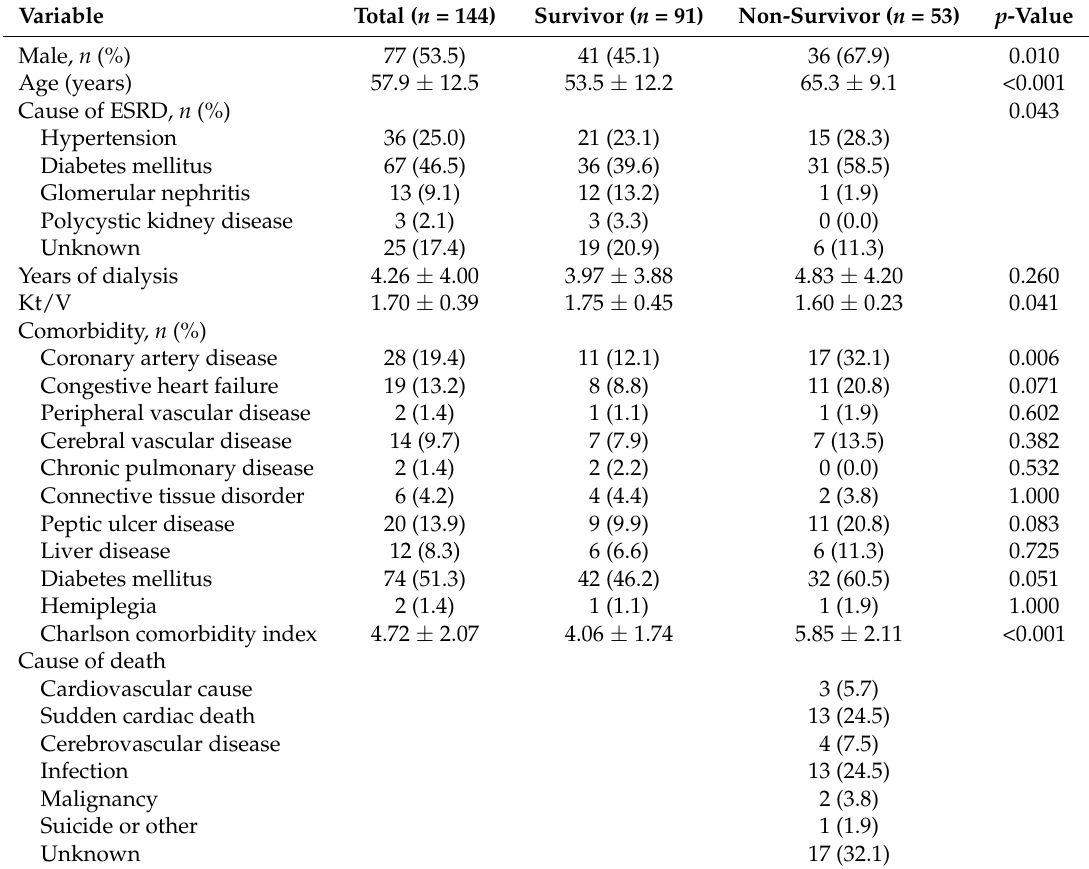
Table 1. Comparison of patient characteristics between the survivor and non-survivor groups. Variable Total ( n =